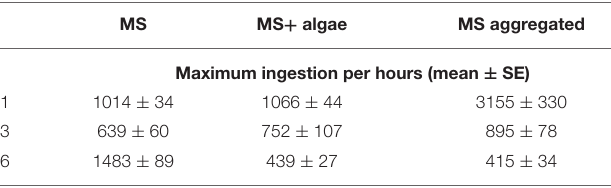
TABLE 5 | The highest ingestion of microspheres per rotifers per hours. MS MS +